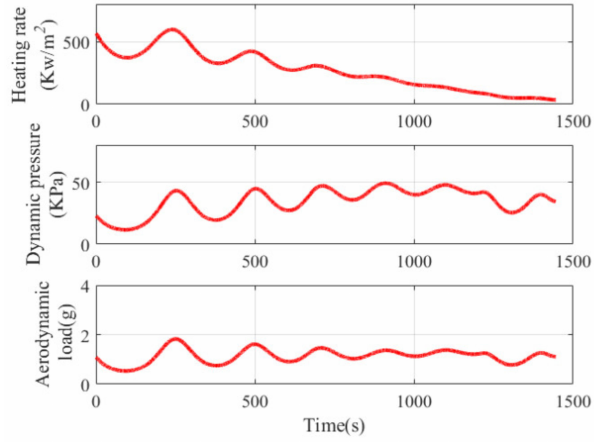
Figure 7. Quasi-ballistic coefficients versus